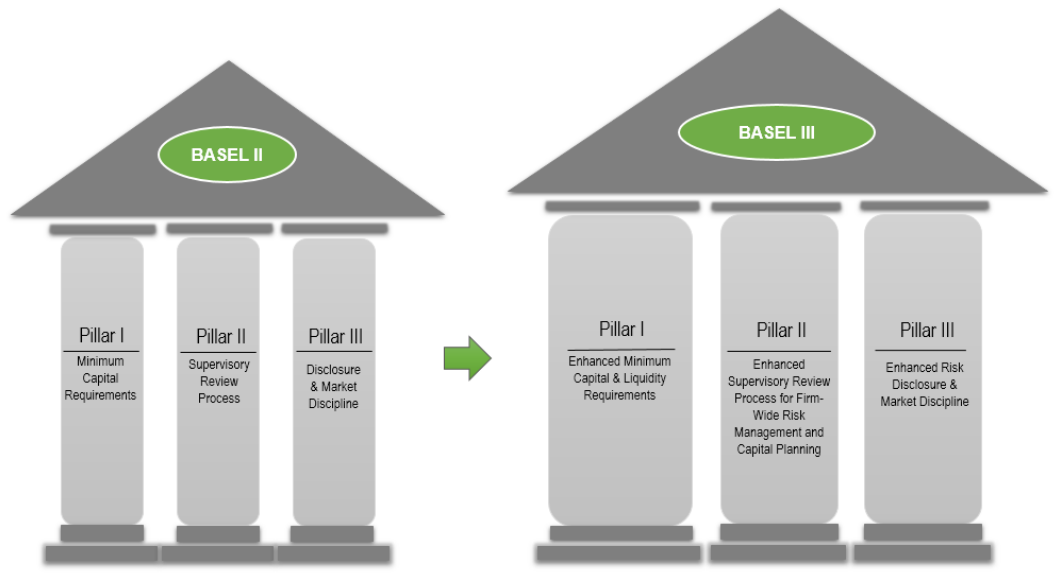
Figure 3. Enhanced requirements from Basel II to Basel III. Source: according to Moody’s Analytics, September 2011.